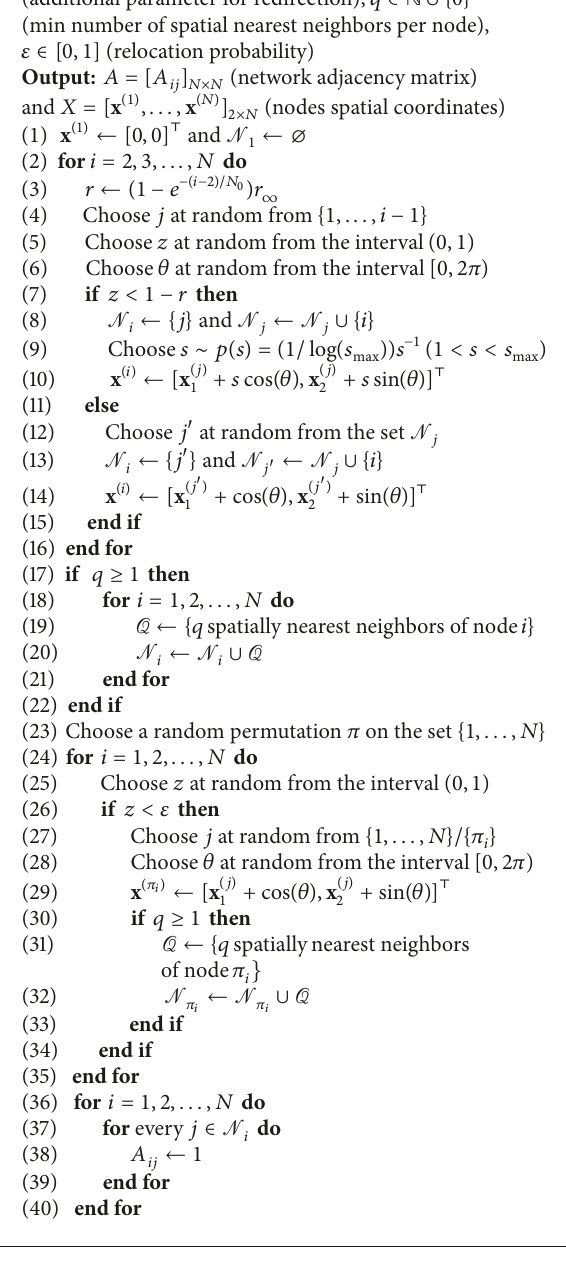
Algorithm 1: Network generation using the SSCN